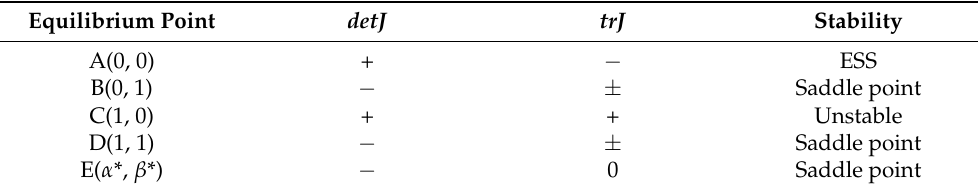
Table 6. Local stability analysis of scenario 4 between local government and coal-related enterprises.